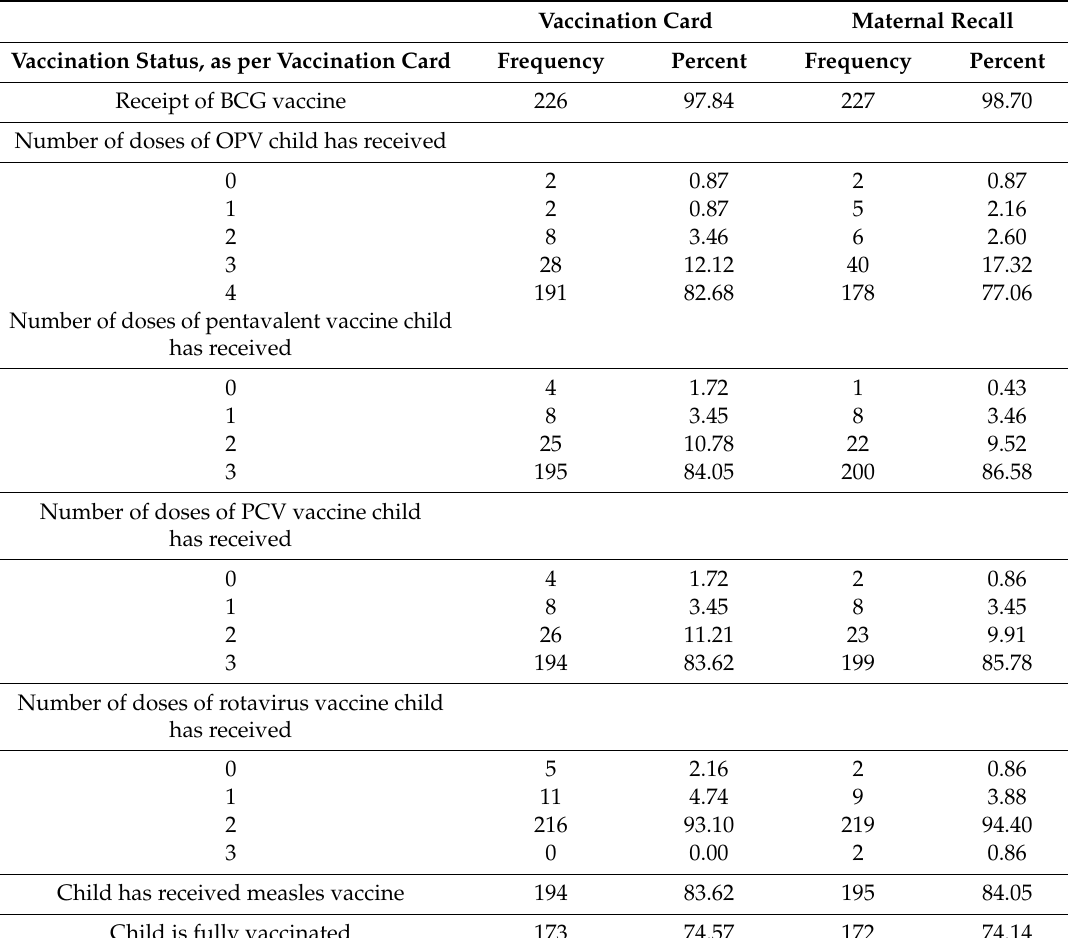
Table 4. Vaccination status of children, according to vaccination card and maternal